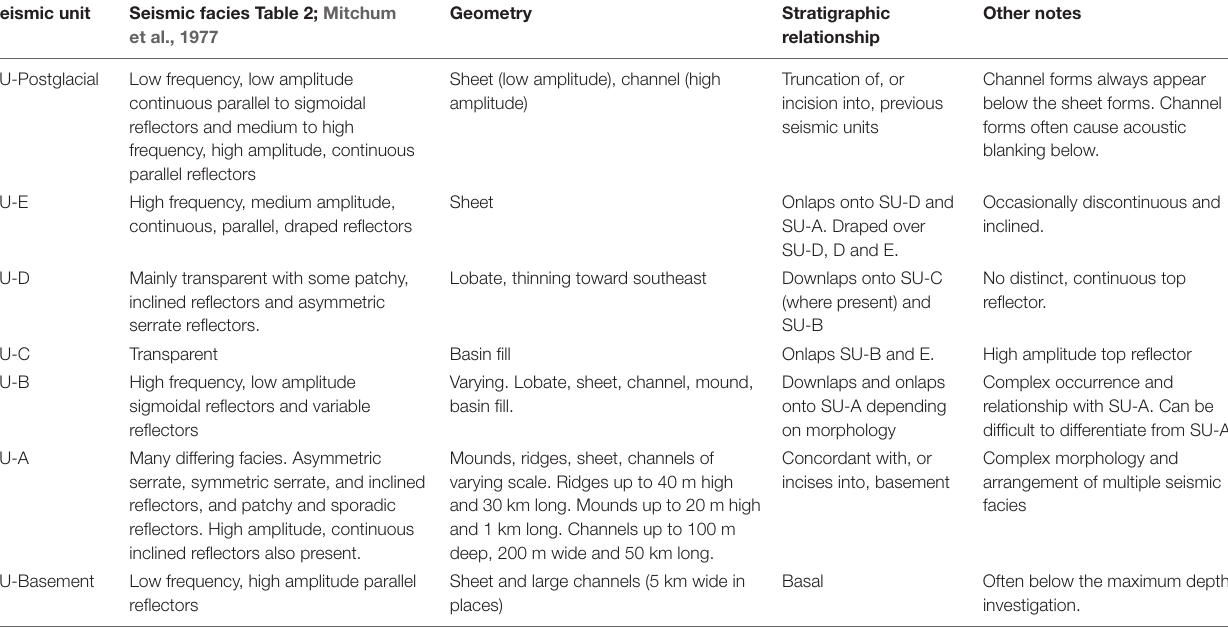
TABLE 3 | Descriptions of seismic facies, stratigraphic relationships and geometry used to define the seismic units (SUs) in this